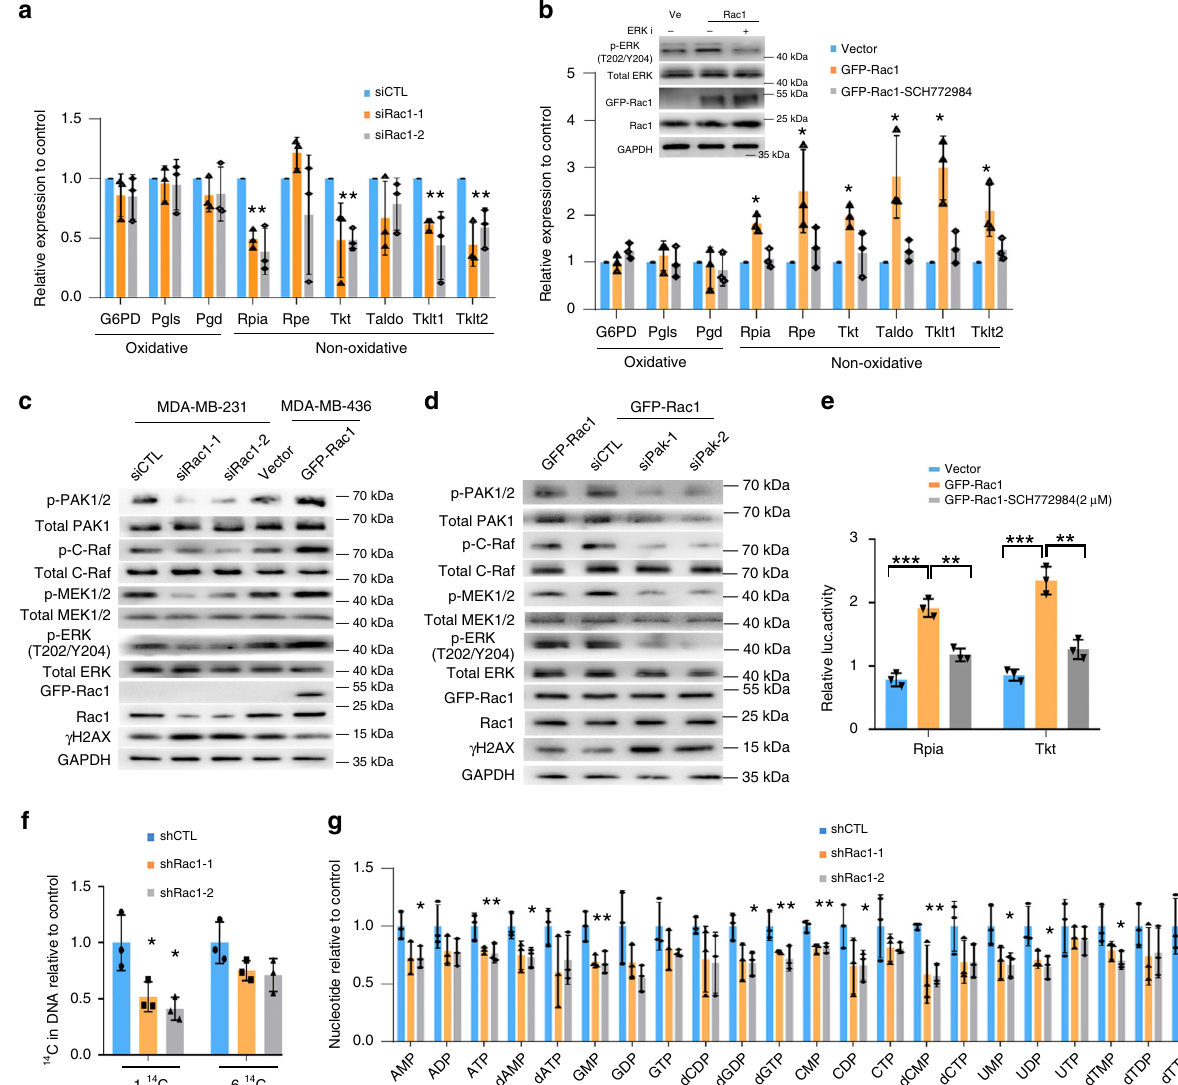
Fig. 4 Rac1 regulates non-oxidative pentose phosphate pathway via ERK signaling. a Rac1 knockdown decreased mRNA levels of PPP enzymes in MDA- MB-231 cells. Expression of PPP enzymes were quanti fi ed by qRT-PCR, and normalized to GAPDH expression in siCTL cells. Bar graphs represent the mean ± SD of three independent experiments. b Exogenous expression of Rac1 increased the level of PPP enzymes, which could be reversed by ERK inhibition in MCF-7 cells. The mRNA levels of PPP enzymes were quanti fi ed by qRT-PCR. Bar graphs represent the mean ± SD of three independent experiments. * p < 0.05. c Manipulating Rac1 expression affected PAK1/2 phosphorylation and the c-Raf/MEK/ERK signaling in breast cancer cells. The result was obtained over three independent experiments. d Exogenous expression of GFP-Rac1 activated c-Raf/MEK/ERK cascade, which could be reversed by PAK1 knockdown. MDA-MB-436 cells were transiently transfected with GFP-Rac1 or siPAK1. The result was obtained over three independent experiments. e Luciferase assay revealed that the transcription of PPP enzymes Rpia and Tkt was activated by Rac1 overexpression, which could be reversed by ERK inhibition. MDA-MB-436 cells with exogenous GFP-Rac1 were used. (Rpia Vector vs GFP-Rac1 p = 0.0003, GFP-Rac1 vs SCH772984 p = 0.0016, Tkt Vector vs GFP-Rac1 p = 0.0004, GFP-Rac1 vs SCH772984 p = 0.0022, two-sided unpaired t -test). Bar graphs represent the mean ± SD of three independent experiments. f Rac1 knockdown reduced the carbon fl ux of non-oxidative PPP. Carbon fl ux from glucose to ribose was determined by 14C-glucose derived carbon incorporated DNA in MDA-MB-231 cells. 14C-uptake in shRac1 cells was displayed, with experimental triplicates ± SD, normalized to 14C-uptake in control cells. Bar graphs represent the mean ± SD of experimental triplicates. g Silencing Rac1 caused a reduction of nucleotides pool. The MDA-MB-231 cells were treated as in a , and the lysis was prepared for mass spectrometry analysis. Bar graphs represent the mean ± SD of experimental triplicates. * p < 0.05, ** p < 0.01, and *** p < 0.001. Source data are provided as a Source Data fi combination of shRac1 and cisplatin (Fig. 6f and Supplementary Fig. 5B). Ki67 and cleaved Caspase-3 (CC3) staining also con- fi rmed the decreased proliferation and increased apoptosis in the IHC staining of the tumor sections con fi rmed the decreased level of xenografts (Fig. 6g, h and Supplementary Fig. 5C, D). Rac1 and p-ERK in shRac1 tumors (Fig. 6d, e and Supplementary The MCF-7 WT and MCF-7DR cells with or without inducible Rac1 knockdown (Plko-tet-on) were also used for xenograft experiments. Nude mice were implanted with 1.7 mg 17 β -estradiol